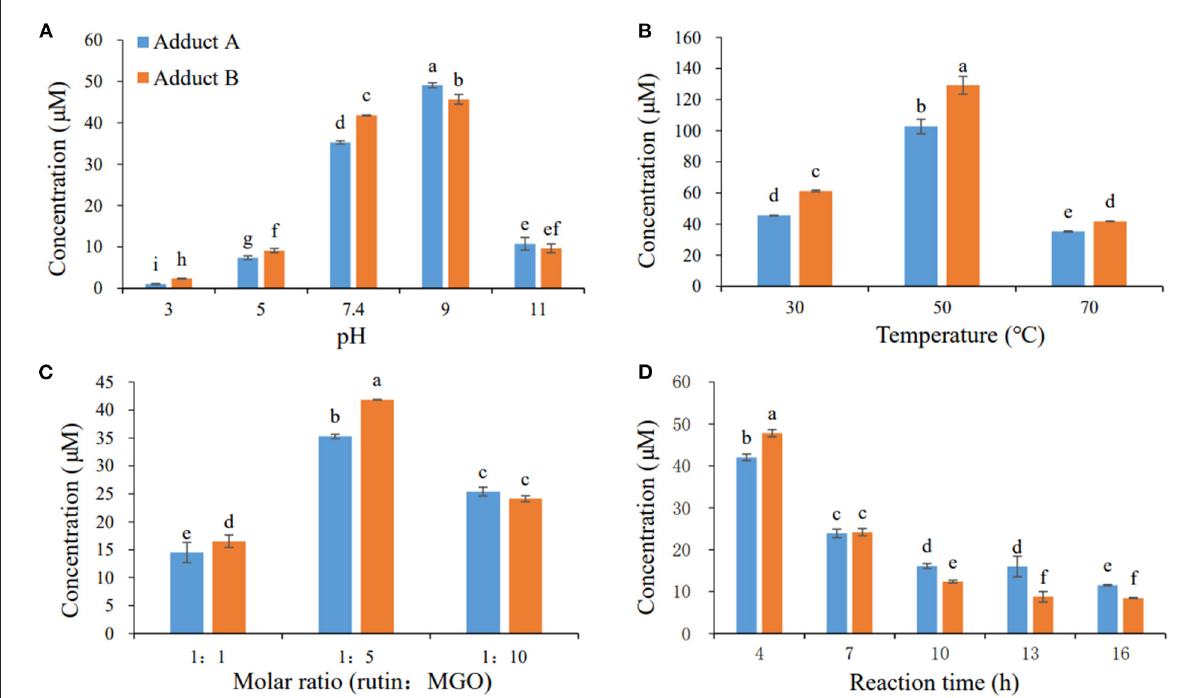
FIGURE2 Effects of pH (A) , temperature (B) , molar ratio (C) , and reaction time (D) on the formation of adducts A and B. Different letters represent significant differences ( P <